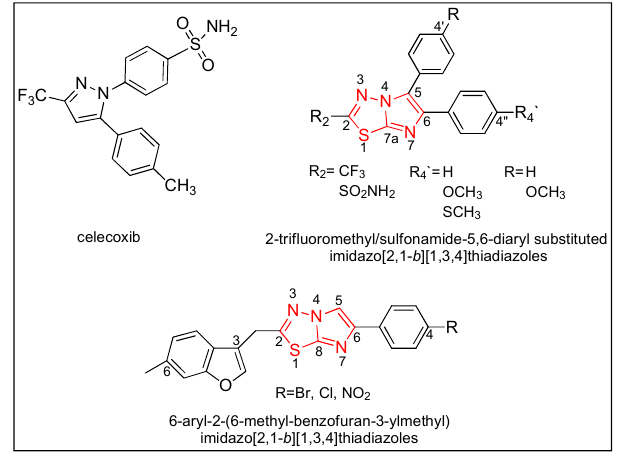
Figure 1. Structures of the literature lead compounds (Reproduced with permission from [Journal of Saudi Chemical Society]; published by [Elsevier]; No.